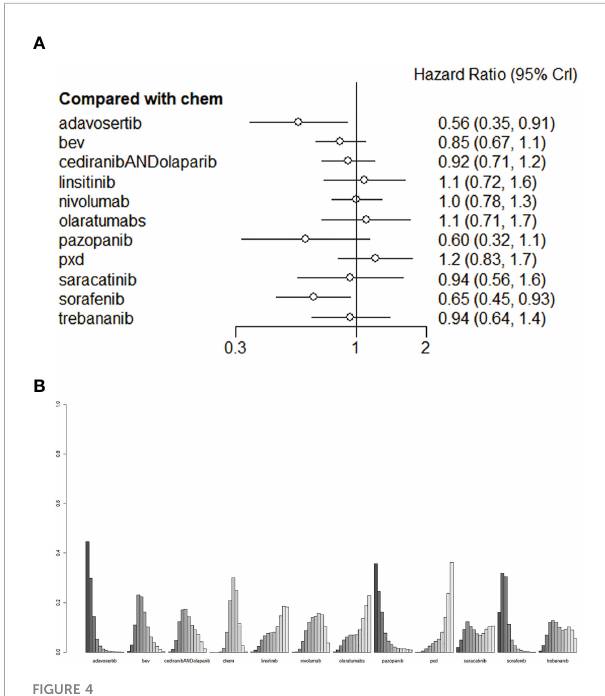
FIGURE 4 (A) The forest plot and (B) the ranking plot for OS. The color of the lines in Figure 4B from dark to light represents the ranking from the best to the worst. A darker color represents a higher probability of becoming the best intervention, and a lighter color represents a lower probability. The cediranibANDcediranib stands for combination